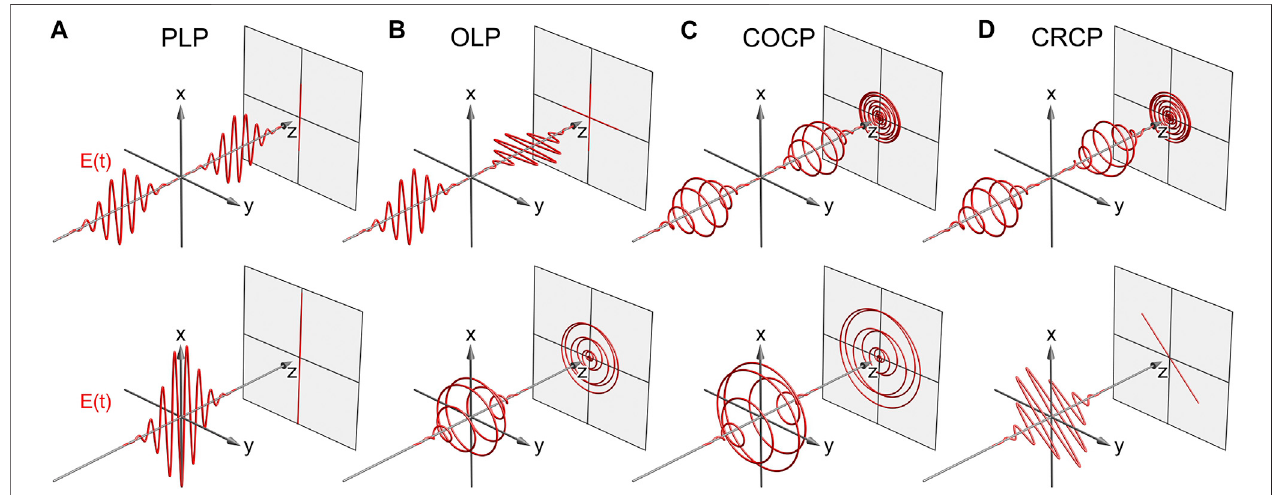
FIGURE4| Single-colorpulsesequences.Theprojectionin z -directionvisualizesthetime-dependentelectric fi eldvectoratthepositionoftheatomormolecule. (A) PLP, (B) OLP, (C) COCPand (D) CRCPsingle-colorpulsesequences.Upper fi gures: Sequencewithseparatedpulses τ > 2 Δ t ,lower fi gures: Coincidingpulsesat τ (cid:2) 0.